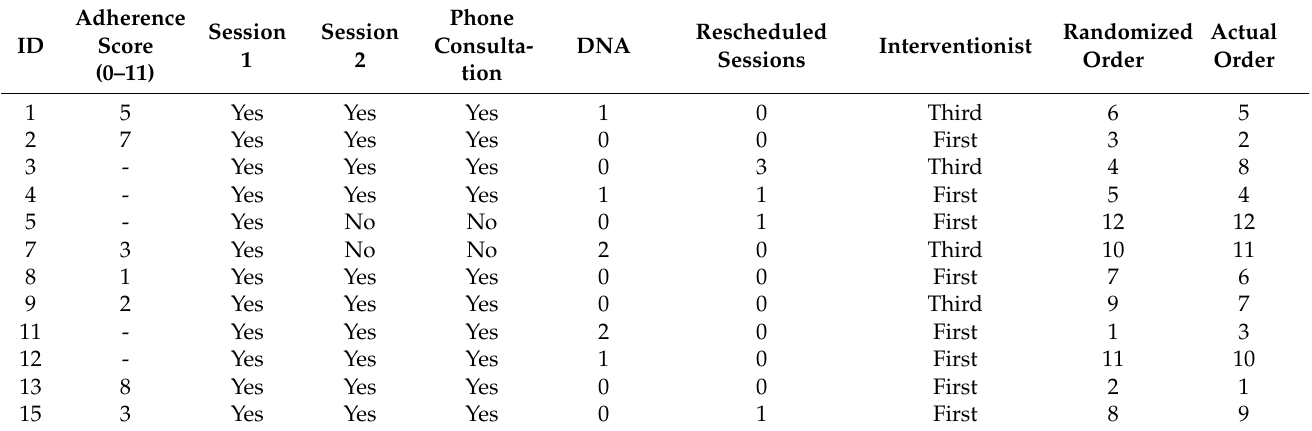
Table 9. Treatment adherence and protocol